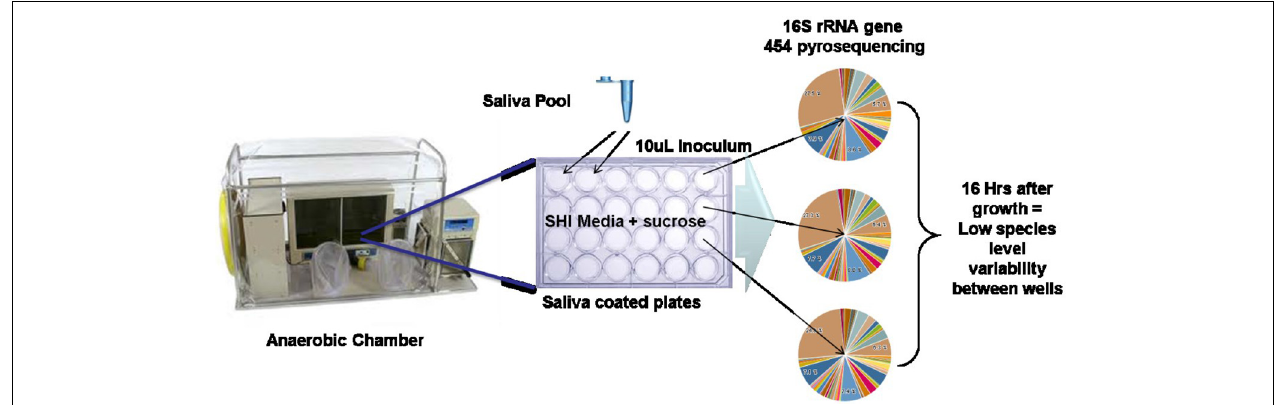
FIGURE 5 | In vitro oral biofilm model system (Edlund et al., 2013). Schematic of in vitro model system growth and 16S rRNA gene sequencing results indicating high reproducibility of taxonomic abundance and carriage between wells.